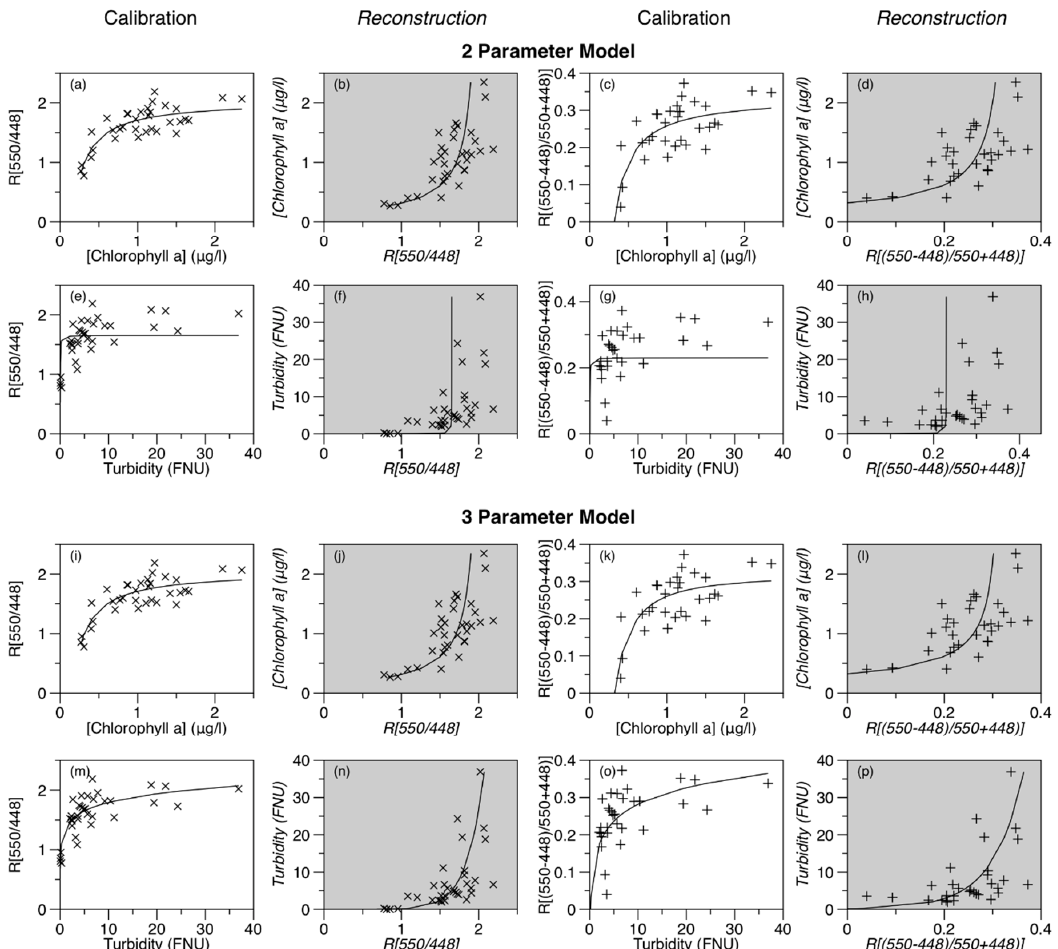
Figure 4. Calibration functions linking [Chl-a] and Turbidity to reflectance ratios and indexes calculated from reflectance measured at λ = 448 nm and λ = 550 nm. From left to right: calibration curve for the R(550) / R(448) ratio, the inversed curve to reconstruct chlorophyll a concentration and Turbidity from the reflectance ratio (grey background), calibration curve for (R(550) − R448) / (R550 + R(448)) index and inversed curve to reconstruct chlorophyll a concentration and Turbidity from the reflectance index (grey background). From top to down, Fit of the 2-parameters functions involving [Chl-a] ( a – d ) and turbidity ( e – h ) as explanatory variable, fit of the 3-parameters functions involving [Chl-a] ( i – l ) and turbidity ( m – p ) as explanatory